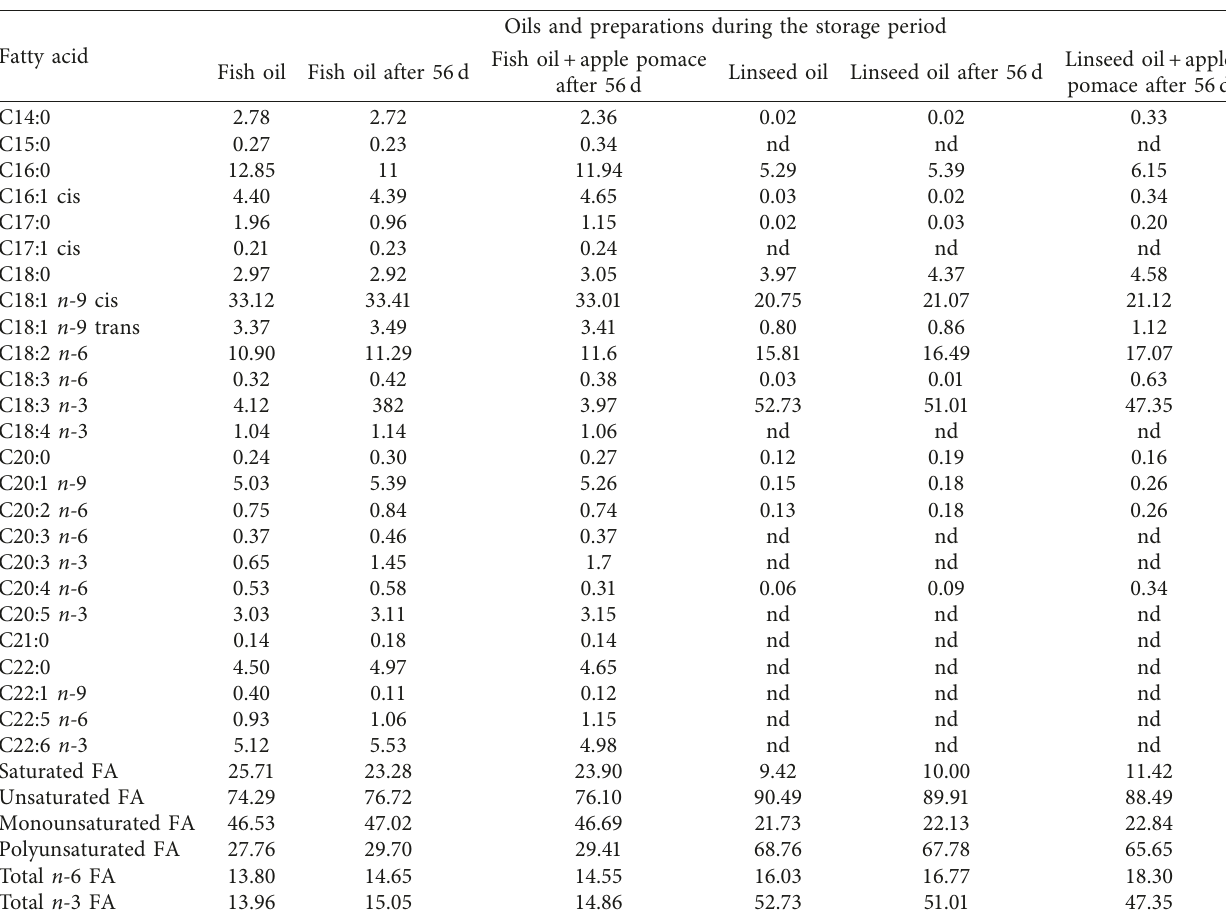
Oils and preparations during the storage